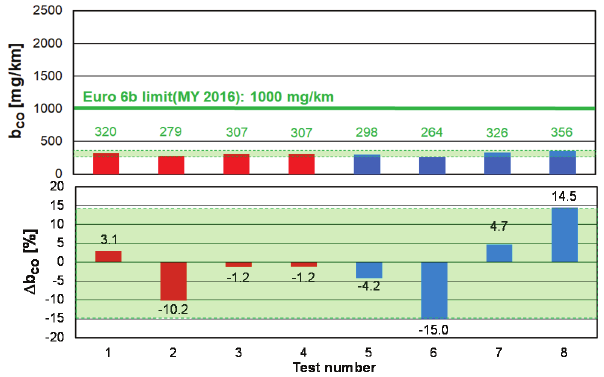
Fig. 8. Vehicle's operating time density in individual speed and accelera- tion intervals for the "reference" drives